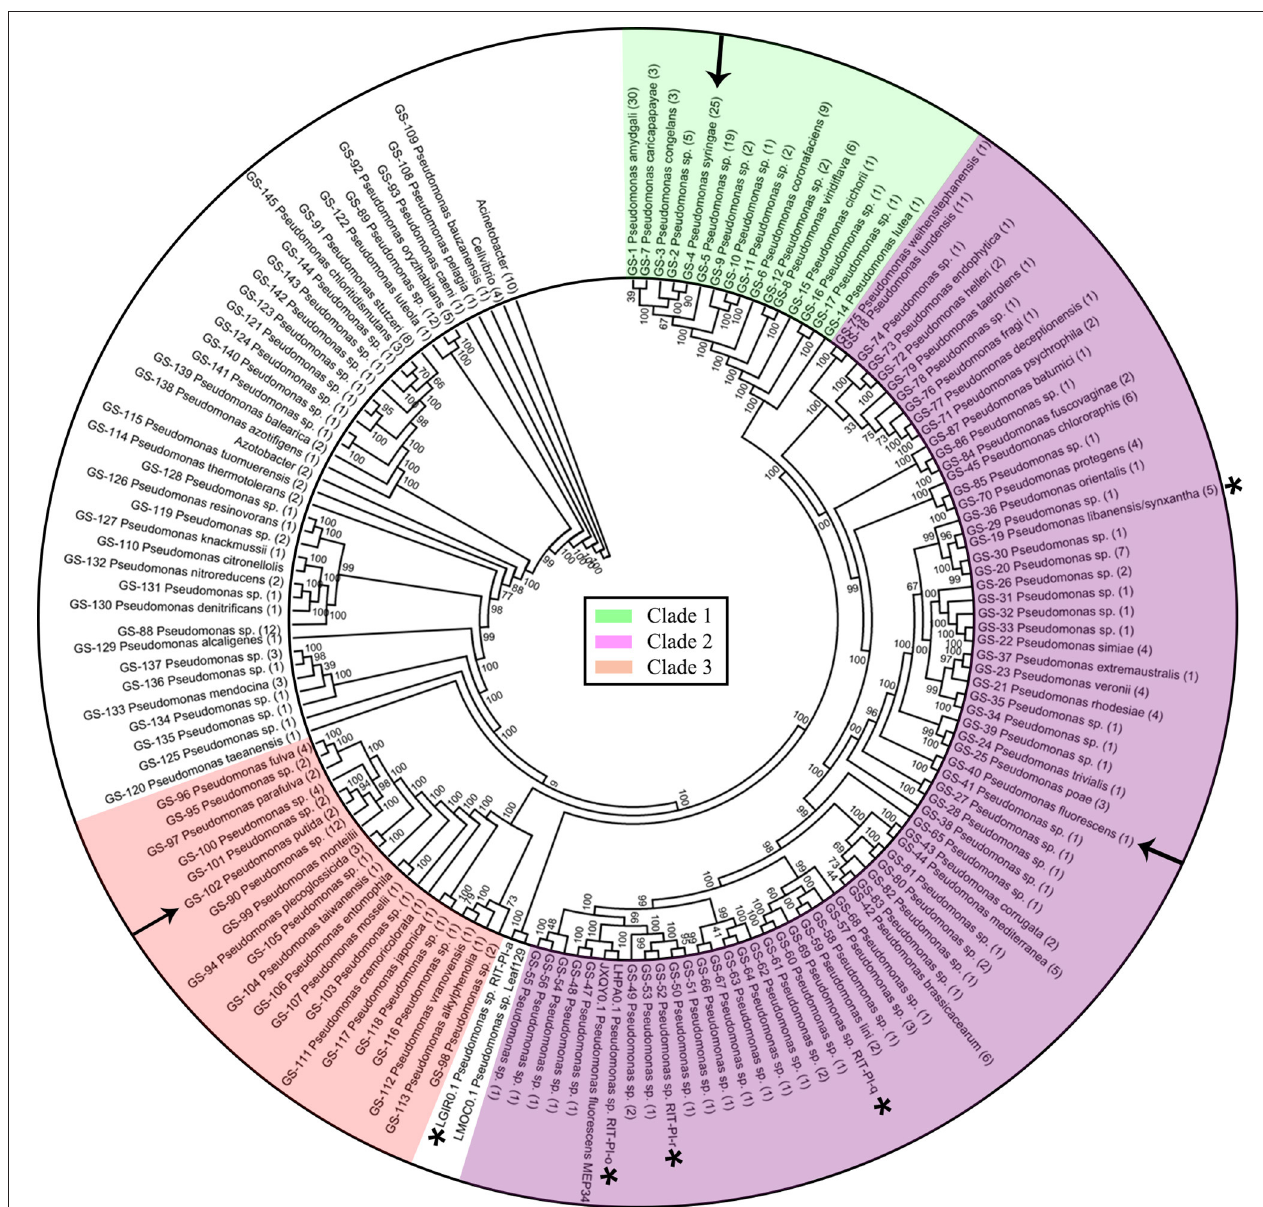
FIGURE 1 | Phylogenomic tree of 373 Pseudomonas strains with corrected taxonomic assignments. Three major clades were colored accordingly with arrows indicating the type strains of 3 common Pseudomonas species e.g., P. putida , P. fluorescens , and P. syringae . Node labels indicate Shimodaira-Hasegawa(SH)-like bootstrap values in percentage. Branches classified as the same genospecies (GS) were collapsed with the number in bracket at the end of each lineage representing the number of whole genome sequences in the corresponding GS. Whole genome sequence of P. syringae , P. fluorescens , and P. putida type strains are indicated with arrows while asterisks-labeled genomes are the five Pseudomonas species isolated from poison ivy vine